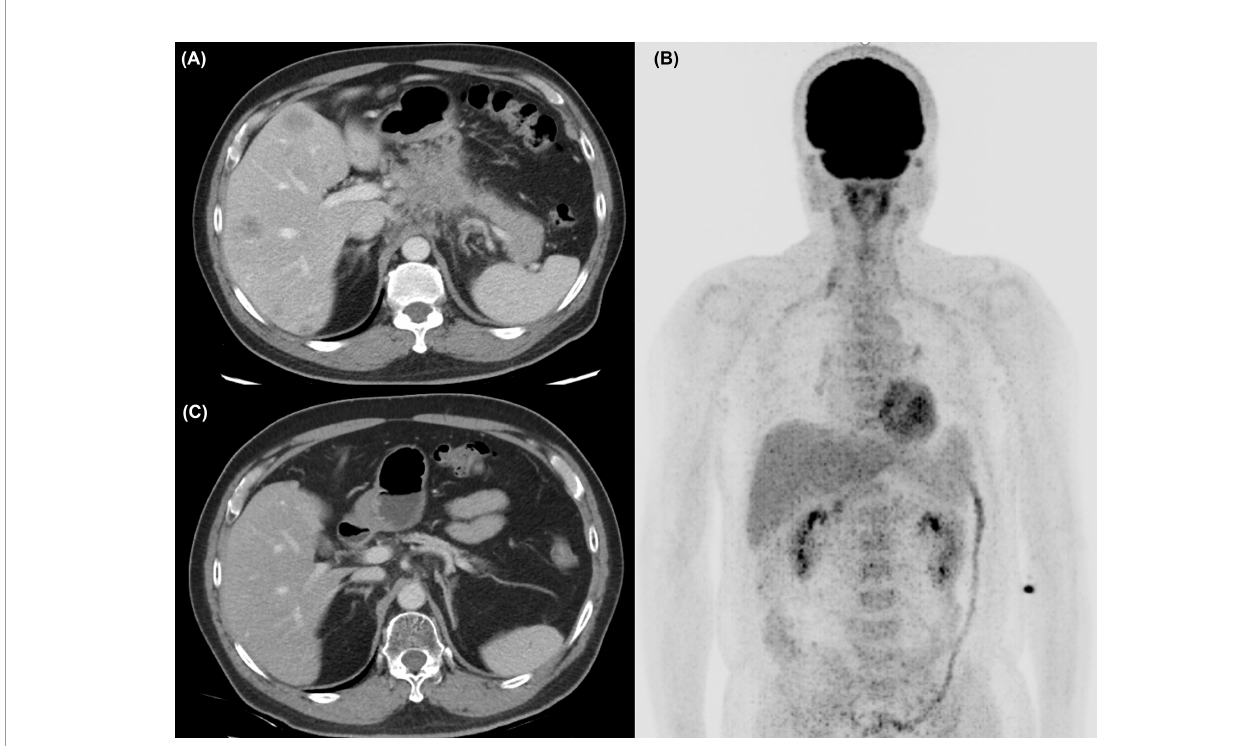
FIGURE 1 | (A) The abdominal computed tomography (CT) scan revealed a 5-cm mass at the pancreatic body with liver metastases at diagnosis. (B) After chemotherapy and RFA of liver metastasis, no [18F]-FDG uptake was identi fi ed at PET scan. (C) At 32 months after initial diagnosis, the patient remains disease-free under maintenance nivolumab